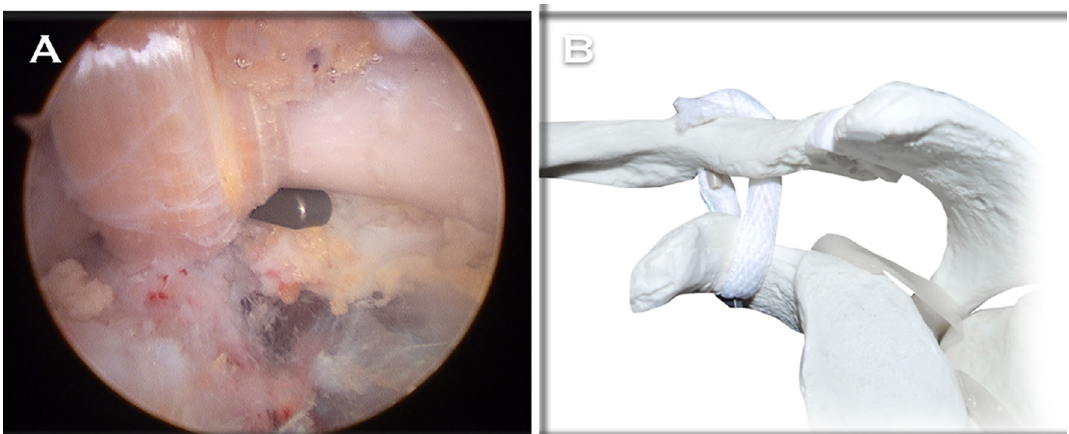
Fig. 6 a Final arthroscopic view from the lateral portal. The graft is coming out of the coracoid tunnel, ascending toward the trapezoid tunnel in the clavicle. The flip of the ZipTight is supported in the inferior aspect of the coracoid. b Final anatomical ’V’ configuration